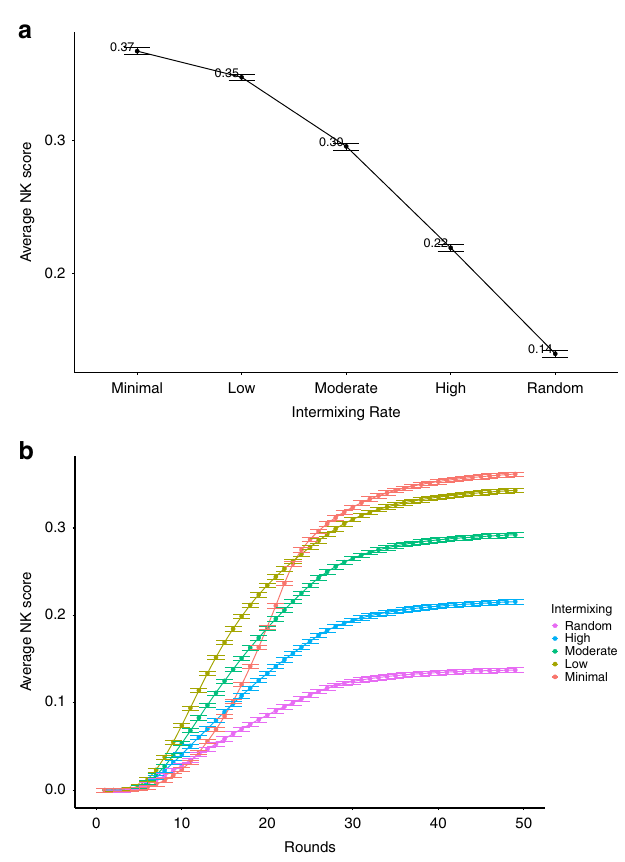
Fig. 6 Diverse knowledge intermixing performance. a The average NK score of networks across problem spaces, plotted by intermixing rates for the diversity of knowledge simulations. b The average NK score of networks across problem spaces, plotted over time for the diversity of knowledge simulations by intermixing rates. Error bars are the standard errors measured across NK